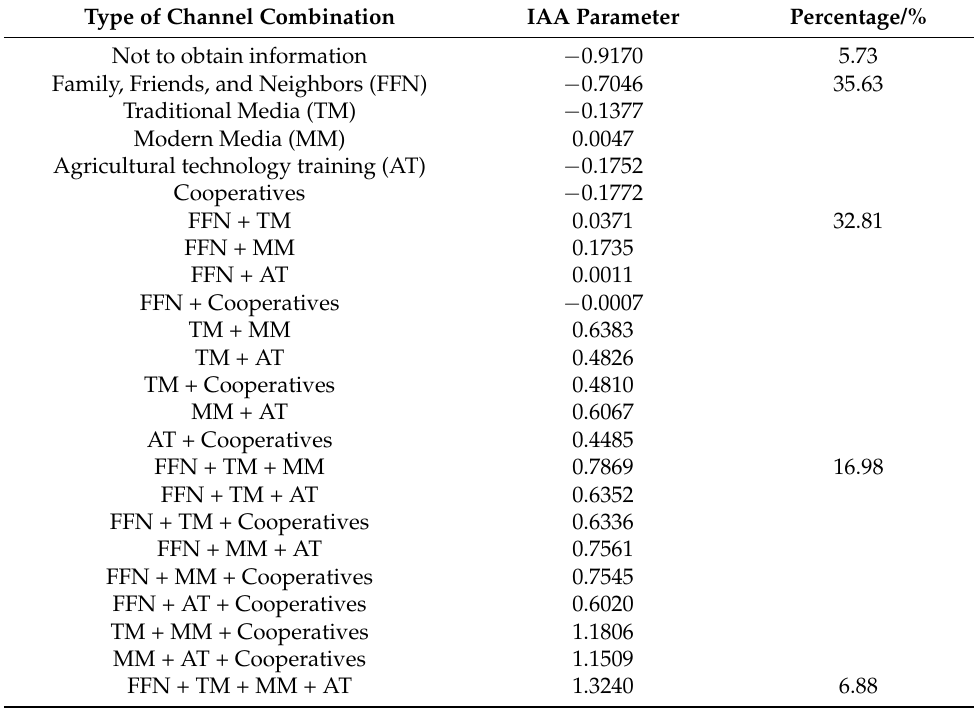
Table 4. Estimation results of IAA